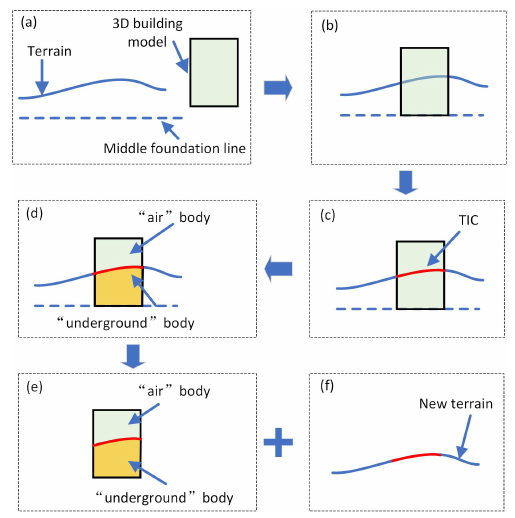
Figure 6. The process of modelling based on 3D building models and